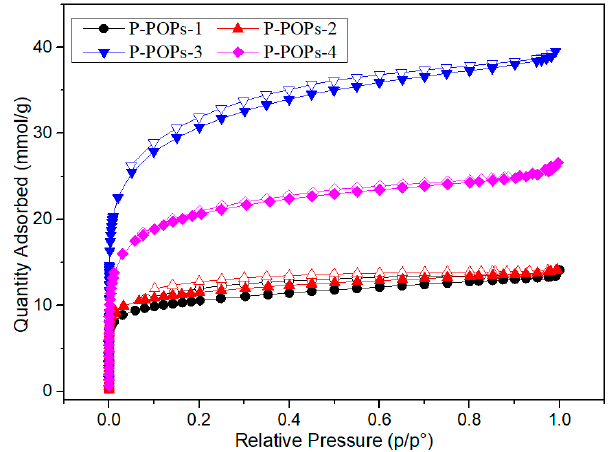
Figure 3. The N 2 isotherms of P-POPs-1, P-POPs-2, P-POPs-3 and P-POPs-4 at 77K.